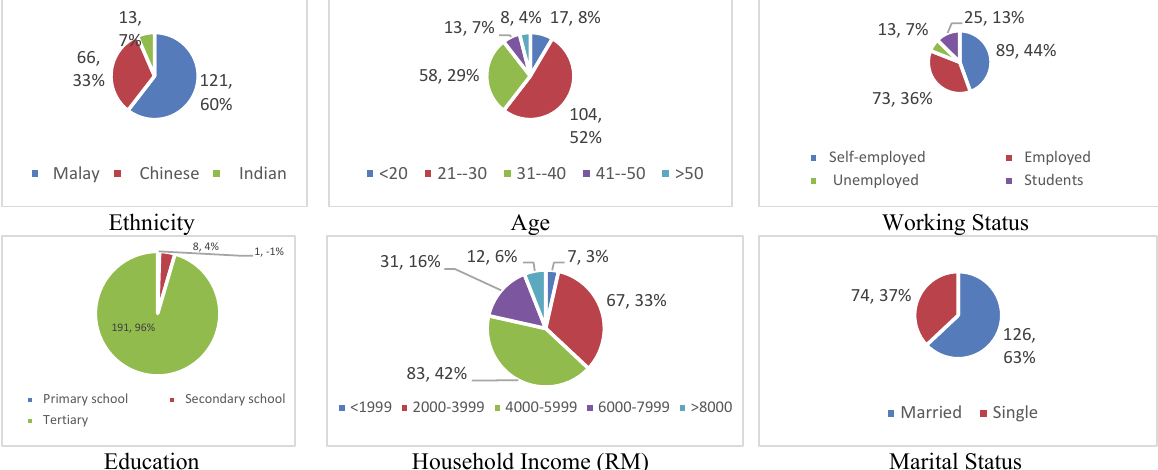
Fig. 1. Demographic profile of 200 pet